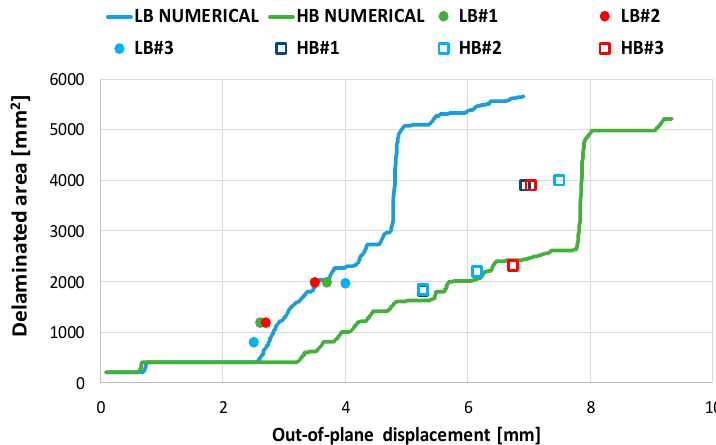
Figure 13. Delaminated area vs. Applied displacements, comparisons between the experimental and numerical results (low (LB) and high bridging (HB) sensitivity).